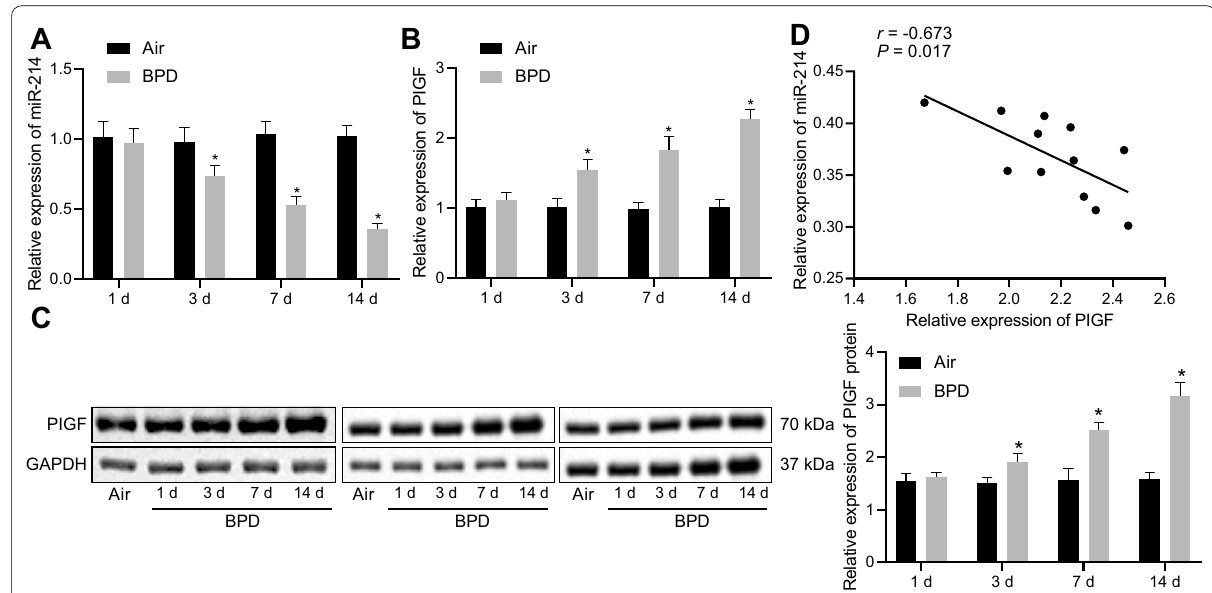
Fig. 2 Decreased miR‑214 expression and increased PlGF expression in the lung tissues of neonatal rats with BPD. A miR‑214 expression in lung tissues of neonatal rats with BPD as determined by RT‑qPCR and normalized to U6. B mRNA level of PlGF in lung tissues of neonatal rats with BPD as determined by RT‑qPCR and normalized to GAPDH. C Western blot analysis of PlGF protein expression in lung tissues of neonatal rats with BPD normalized to GAPDH. D Correlation analysis of miR‑214 and PlGF expression in lung tissues of neonatal rats on the 14th day. The data are summarized as mean standard deviation. * p < 0.05 vs. neonatal rats exposed to air. Data comparisons at different time points were performed ± using two‑way ANOVA, followed by a Bonferroni or Tukey’s post hoc test for multiple comparisons. n 3 for rats in each =